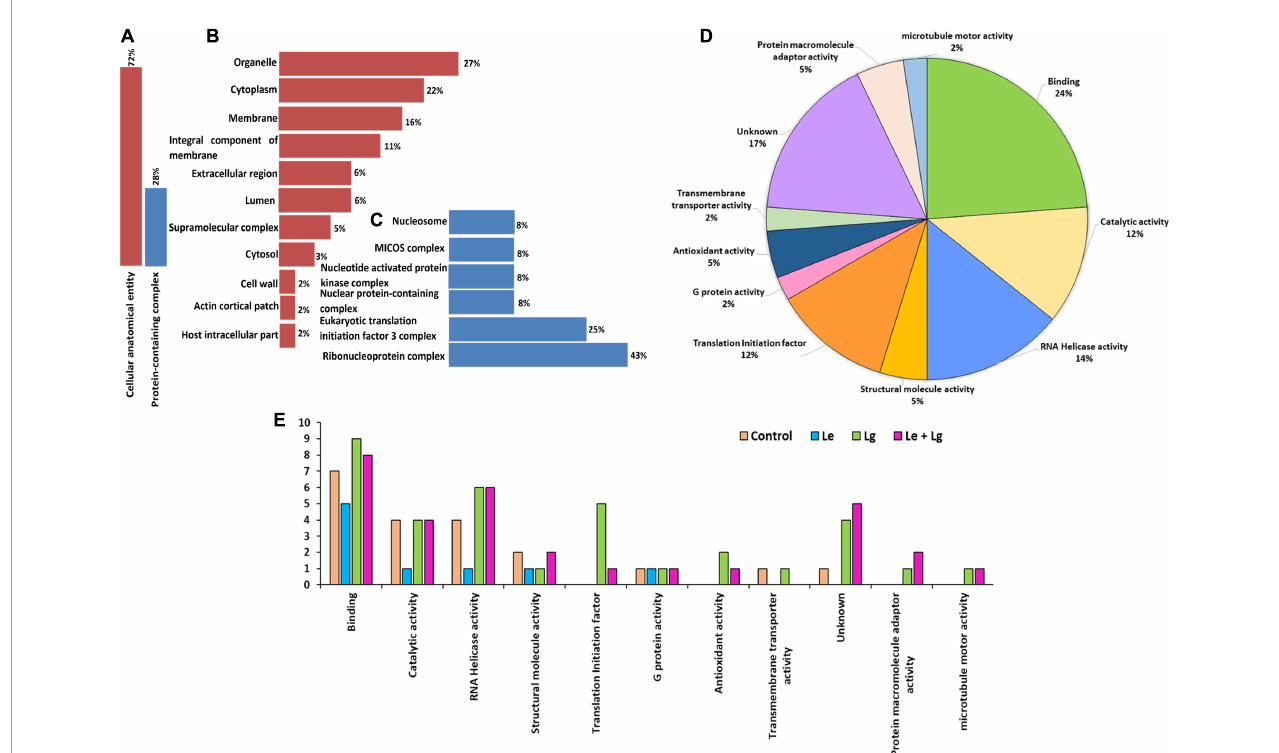
FIGURE4 Cellular compartment analysis of the total number of proteins identified: (A) Percentage distribution of cellular compartments in the cellular anatomical entity, (B) shows a further analysis of 72%, and (C) sub-cellular representation in the protein-containing complex, (D) functional and molecular classification of essential oil responsive proteins identified in B. cinerea and (E) gene ontology (GO) classification annotation of DEPs for treated and untreated B. cinerea and the number of identified proteins for various treatments on y -axis. The functions were categorized according to gene ontology annotations from the UniProt database (https://www.uniprot.org/).